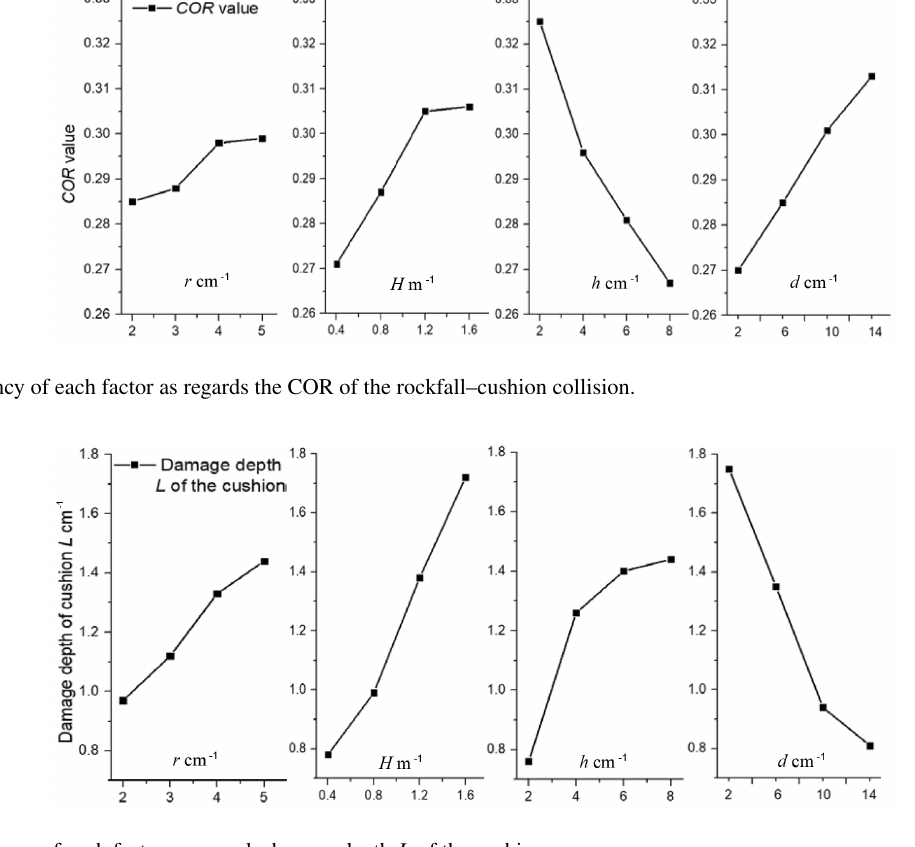
Figure 10. Tendency of each factor as regards damage depth L of the